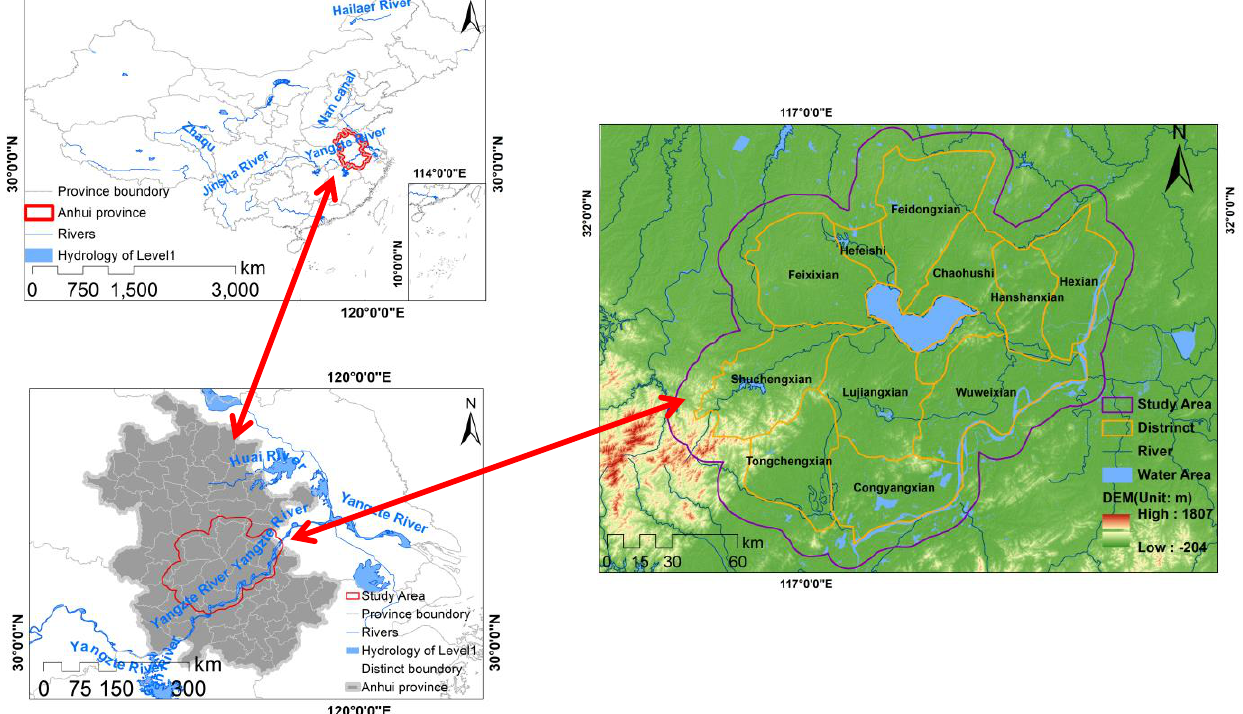
Figure 1. The geographical location of the study area and the DEM of the study area (according to the China basic geographic information, 2008